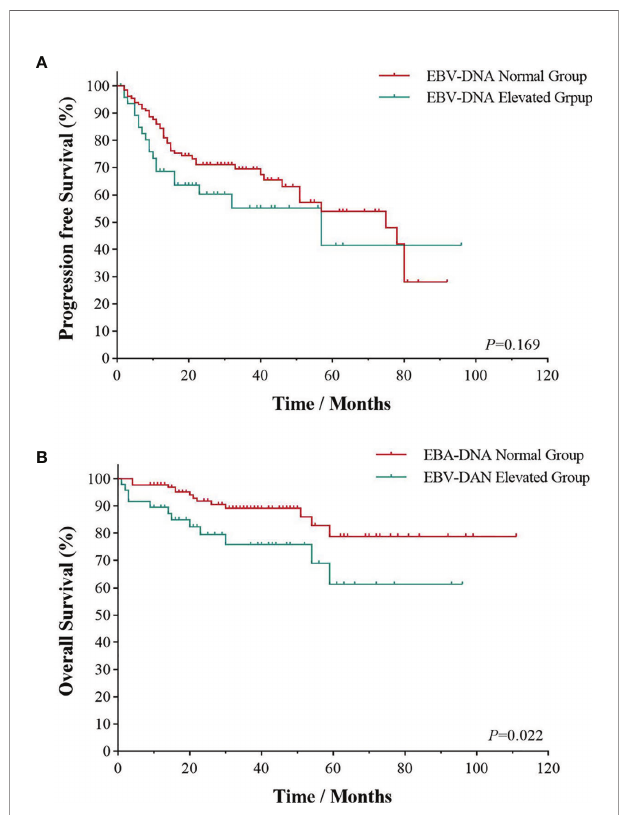
FIGURE 3 | Survival analyses by EBV-DNA. Progression-free survival (A) and overall survival (B) of EBV-DNA level of UAT-ENKTL patients. ENKTL, natural killer/T-cell lymphoma, nasal type; UAT, upper aerodigestive tract; EBV, Epstein – Barr